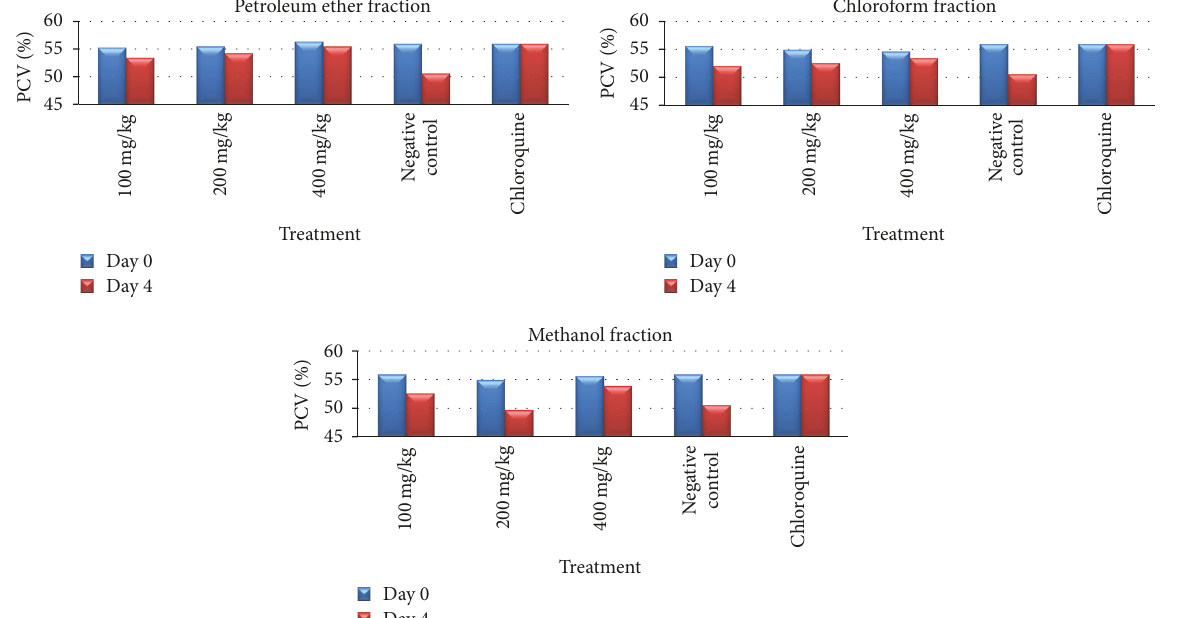
Figure 2: Effect of the solvent fractions of C. papaya root on packed cell volume (PCV) of P. berghei infected mice on 4-day Peter’s suppression